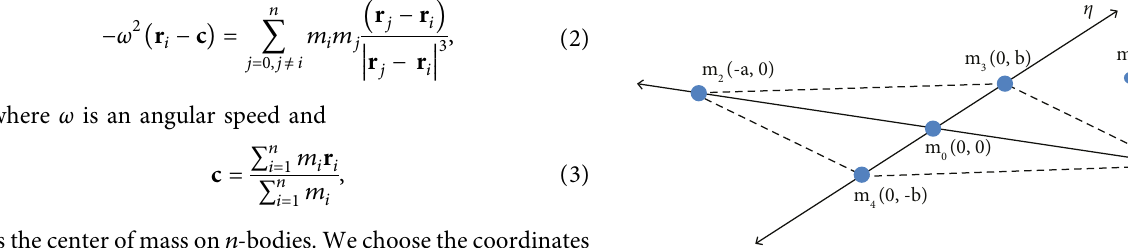
Figure 1: The restricted six-body